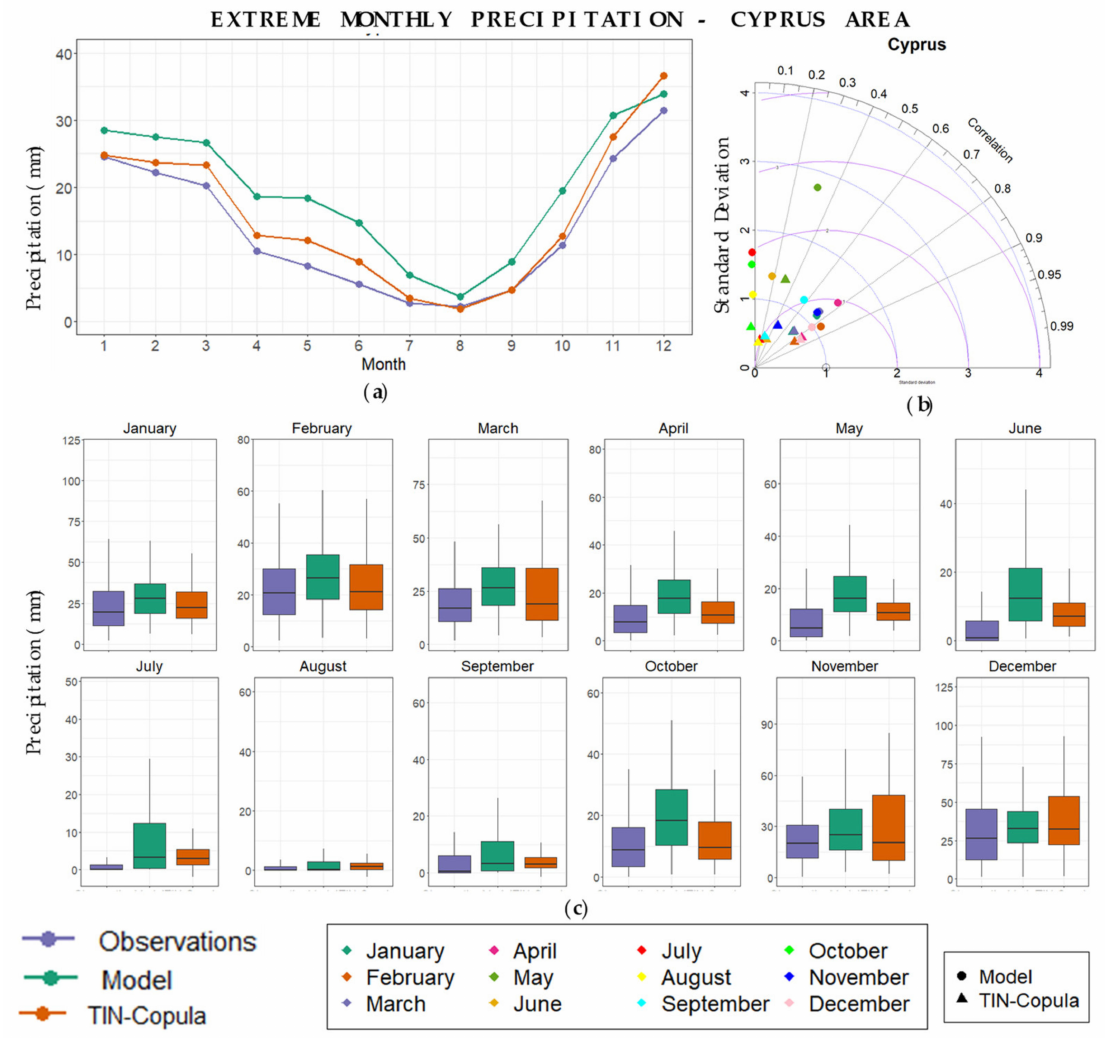
Figure 10. Monthly mean extreme precipitation values in Cyprus for the period of 1986–2000. Presentation with ( a ) line plots, ( b ) Taylor diagram and ( c )